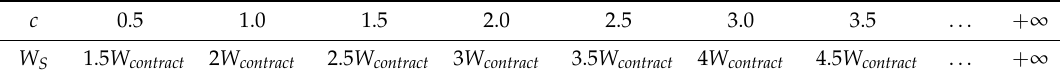
Table A1. Corresponding SW with the di ff erent highest value of the rewarding